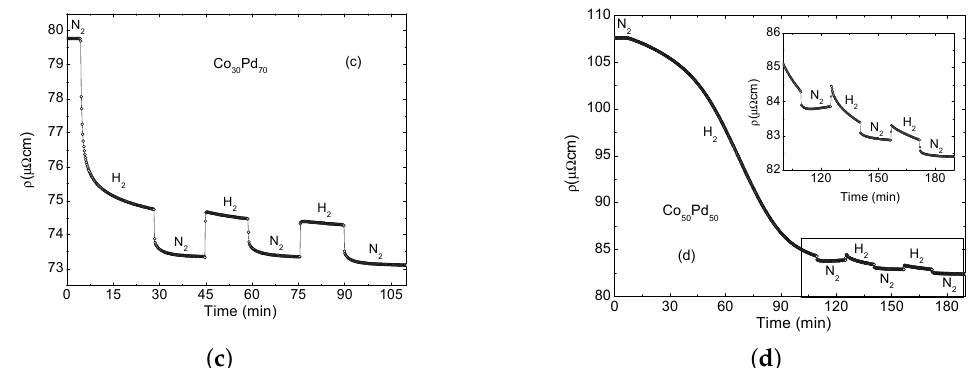
Figure 1. Resistivity response to a sequence of hydrogenation and dehydrogenation cycles (sequential exposure to a 1 atm 4% H 2 / N 2 gaseous mixture followed by N 2 ) of four 15 nm thick samples: pure Pd ( a ) and three Co x Pd 100-x alloys with x = 15 ( b ), x = 30 ( c ) and x = 50 ( d ). The initial atmosphere is N 2 .